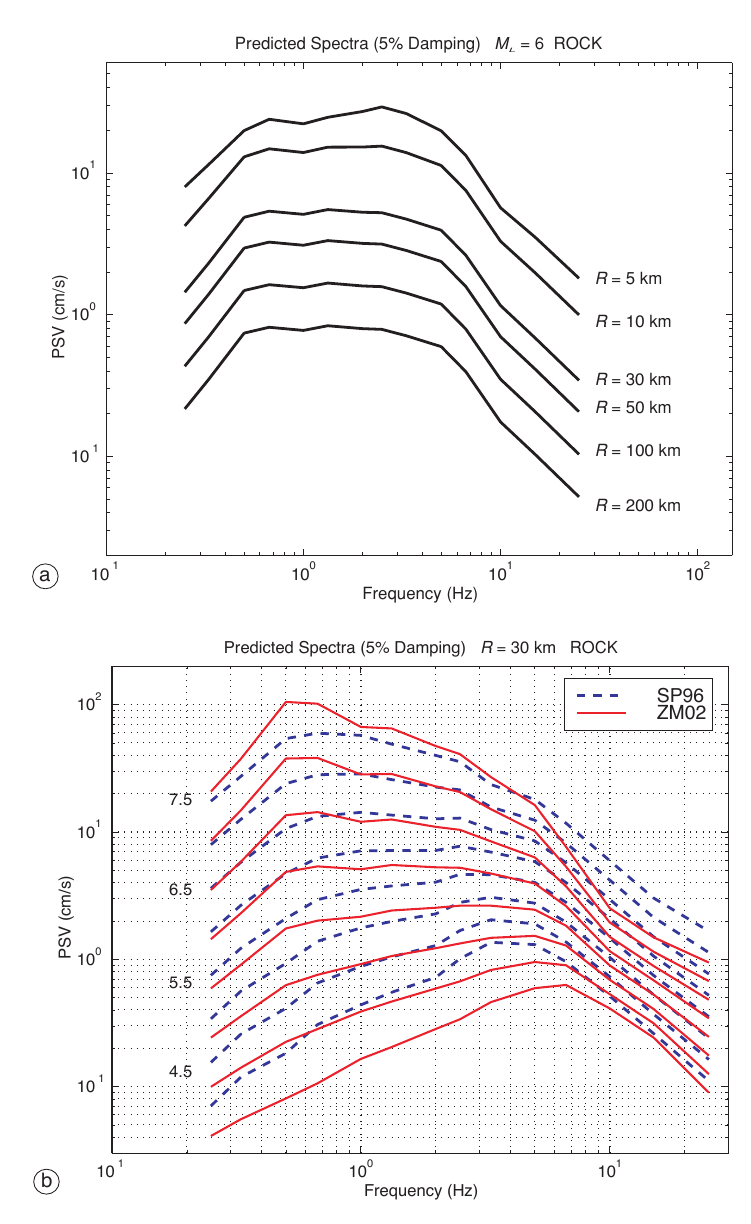
Fig. 5a,b. Figure 5a shows the predicted (5% damping) PSV curves versus the frequency for different values of the epicentral distance ( i.e. R = 5, 10, 30, 50, 100 and 200 km) calculated with the attenuation relations proposed by this study (see table III) for a rock site and local magnitude M = 6. Figure 5b shows a comparison of the L predicted (5% damping) PSV versus the frequency for a fixed epicentral distance ( R = 30 km) and at different levels of local magnitude ( i.e. M ranging between 4 and 7.5, each step is equal to 0.5). The red lines are relative L to the results of this study (ZM02) while the blue dashed curves are SP96 (raw